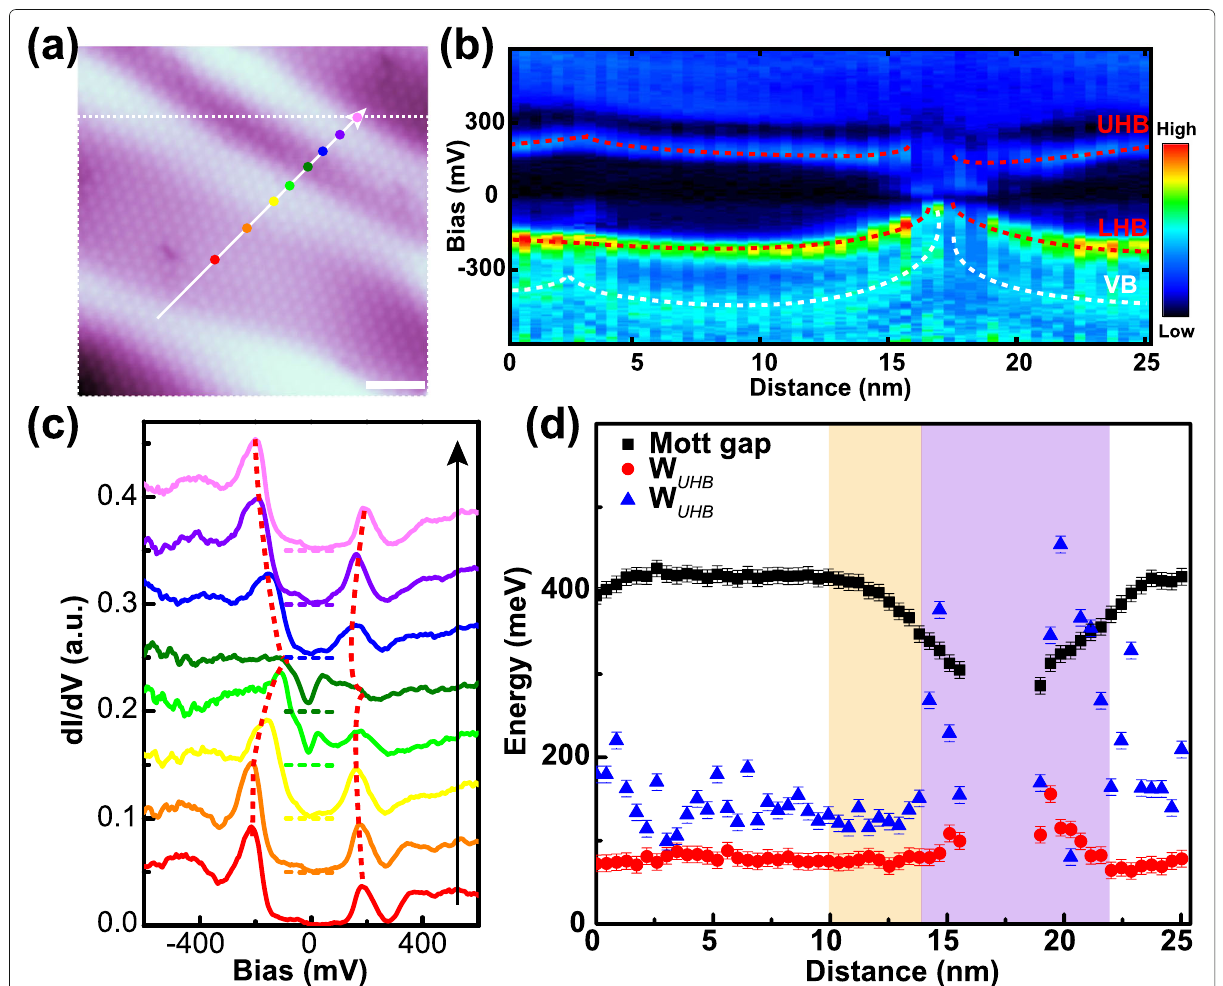
Fig. 11 Mott-gap collapse across the corrugation in 1 T -TaS 2 . a A topographic image with corrugations (30 × 30 nm 2 ). b , c The dI / dV spectra along the white arrowed line and on the positions marked in a . d Evolution of the electronic states across the corrugation. Taken from ref. [51]